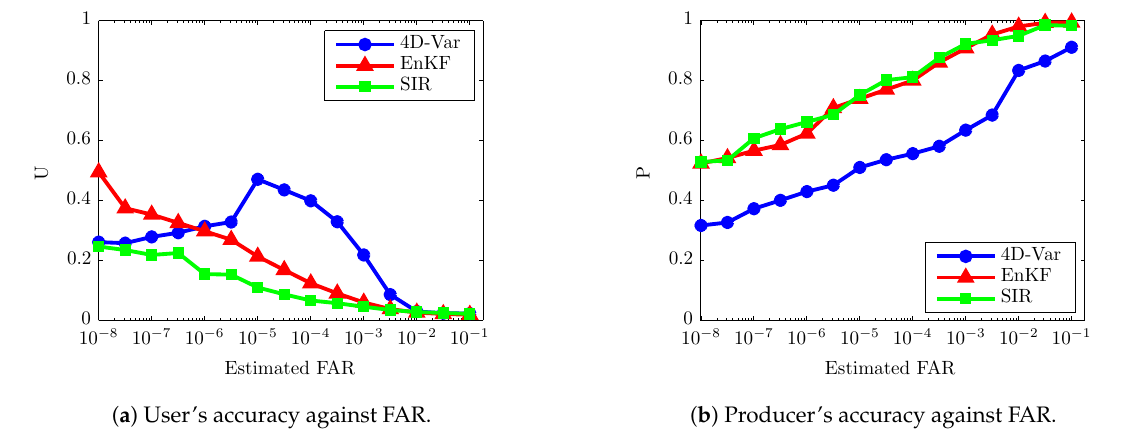
Figure 1. User’s accuracy and Producer’s accuracy against estimated